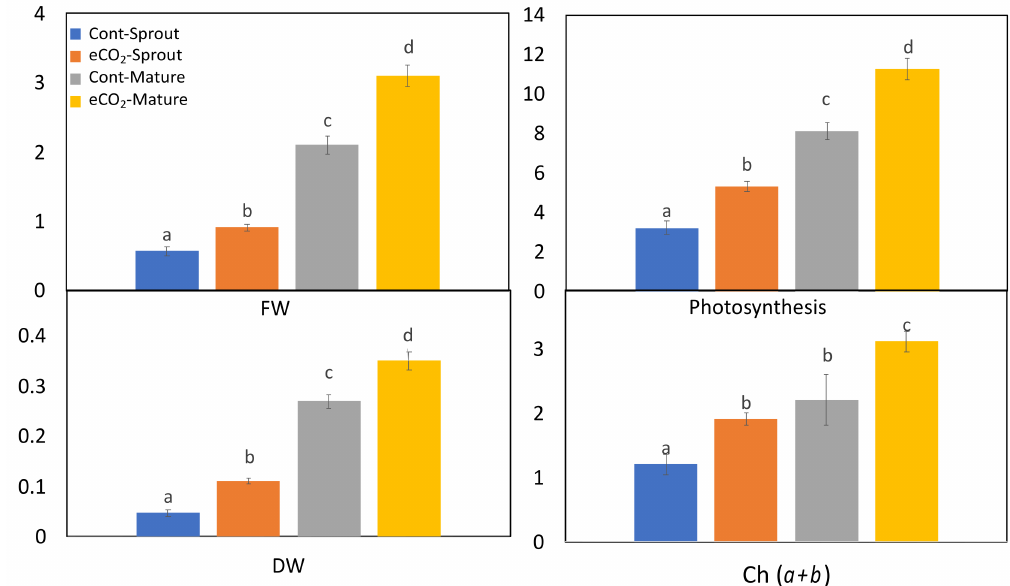
Figure 1. Biomass; fresh weight (FW) (mg/g FW) and dry weight (DW) (mg/g FW), photosynthesis ( µ mol CO 2 m − m s − s ), and pigments content (chlorophyll a + b ) (mg/g FW) of control and eCO 2 -treated caraway sprouts and mature plants. Data are represented by the means of at least 3 replicates ± standard deviations. Different small letter superscripts (a, b, c and d) within a row indicate significant differences between control and eCO 2 -samples. One-way analysis of variance (ANOVA) was performed. Tukey’s test was used as the post-hoc test for the separation of means ( p <